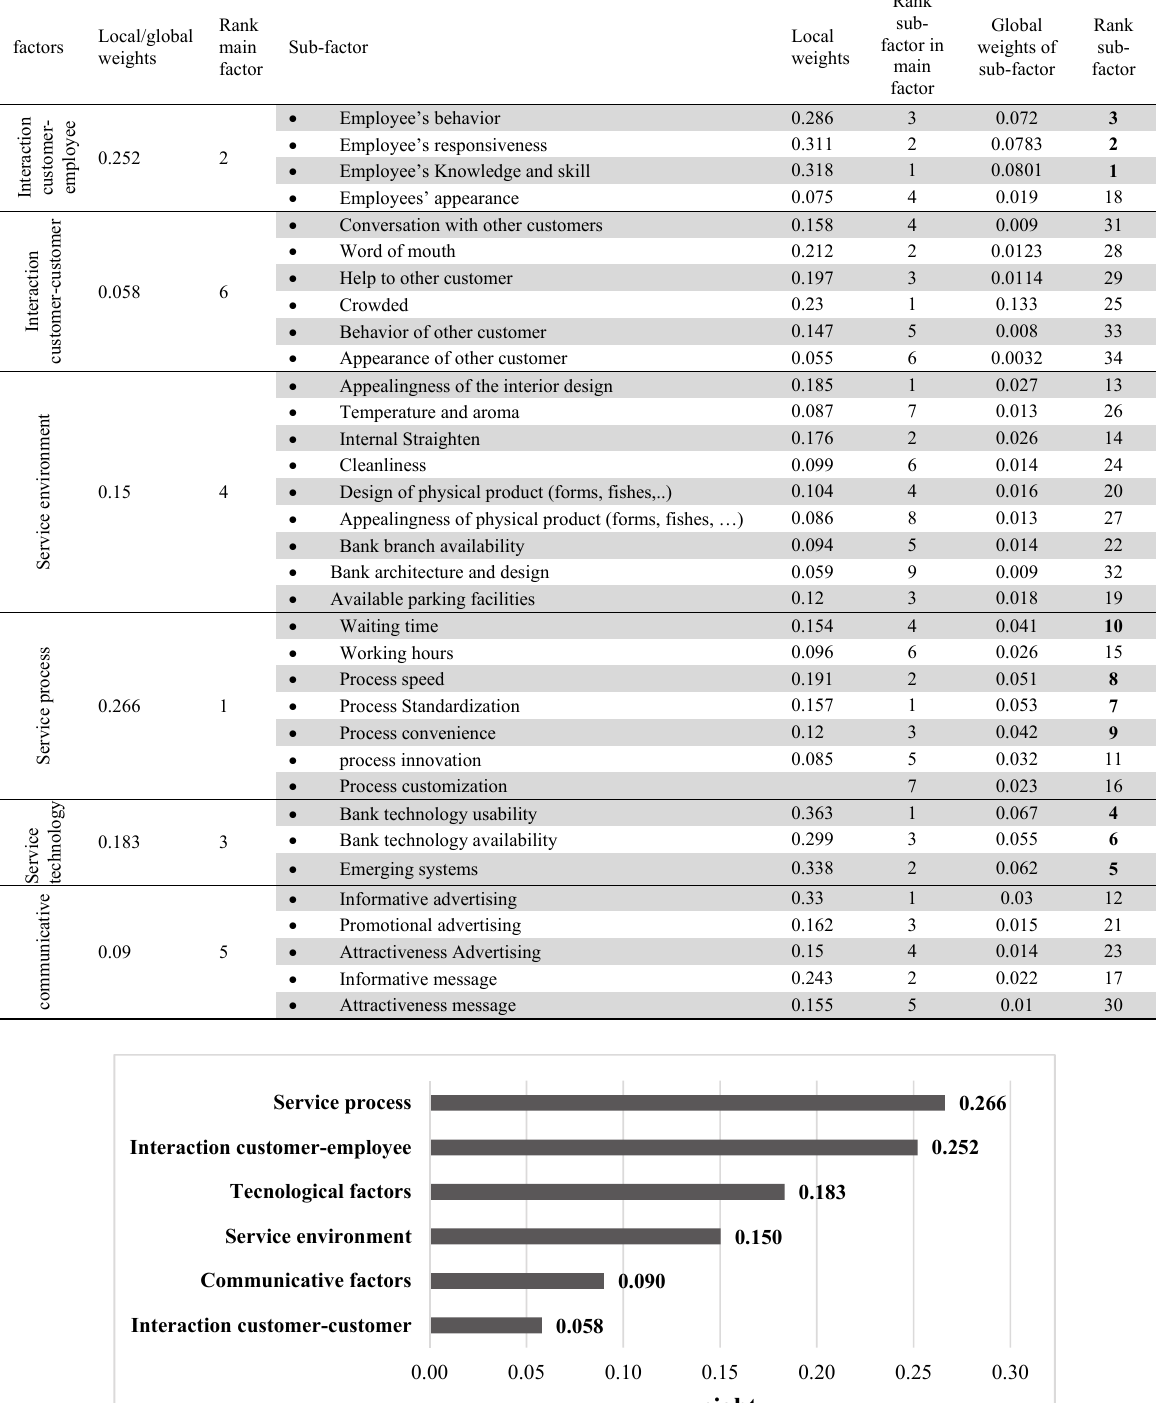
Local/Global weights of factors and sub-factors